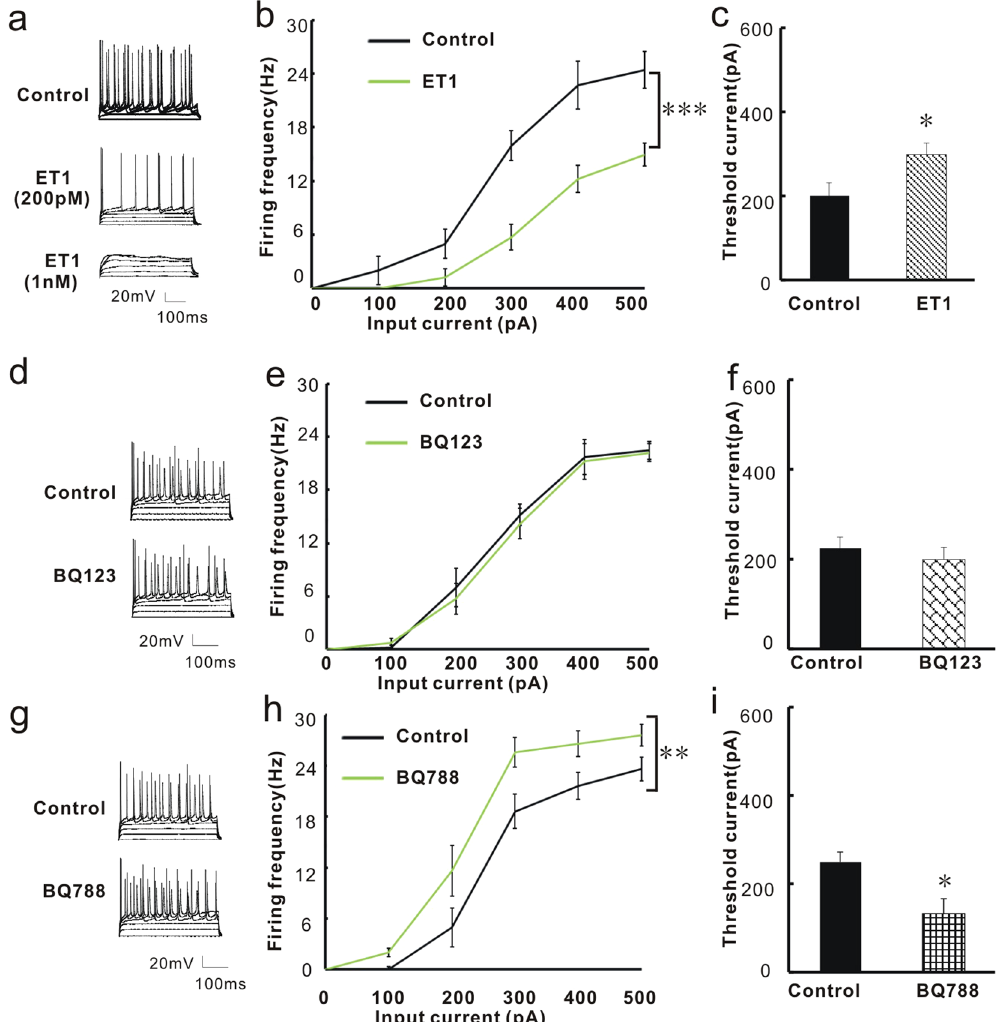
Figure 4. The firing frequency and threshold current of action potential generation are regulated by ET1 and ETBR antagonists. ( a ) Voltage responses of a representative pyramidal neuron in the BLA to current injections of, from bottom to top, 0, 100, 200, 300, 400, and 500 pA. Different concentrations of ET1 solution were applied. ( b ) Summary plot of the firing frequency before and after application of 200 pM ET1 (n = 8/ group). ( c ) Summary histogram of the threshold current for action potential before and after application of 200 pM ET1 (n = 8/group). ( d ) Voltage response of a representative pyramidal neuron in the BLA to current injections of, from bottom to top, 0 to 500 pA, before and after BQ123 treatment. ( e ) Summary plot of the firing frequency before and after application of 1 nm BQ123 (n = 8/group). ( f ) Summary histogram of the threshold current for action potential before and after application of 1 nm BQ123 (n = 8/group). ( g ) Voltage response of a representative pyramidal neuron in the BLA to current injections of, from bottom to top, 0 to 500 pA, before and after BQ788 treatment. ( h ) Summary plot of the firing frequency before and after application of 2 nM BQ788 (n = 6/group). ( i ) Summary histogram of the threshold current before and after application of 2 nM BQ788 (n = 6/group). * P < 0.05, two-way ANOVA test with one factor as repeated measure for 4b, 4e and 4 h and Student’s t test for 4c, 4f and